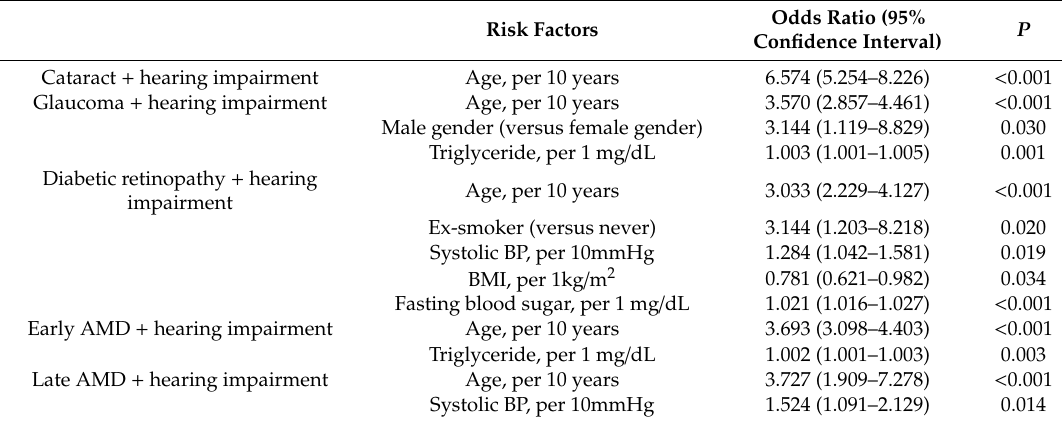
Table 6. Risk factors for concurrent eye diseases and hearing